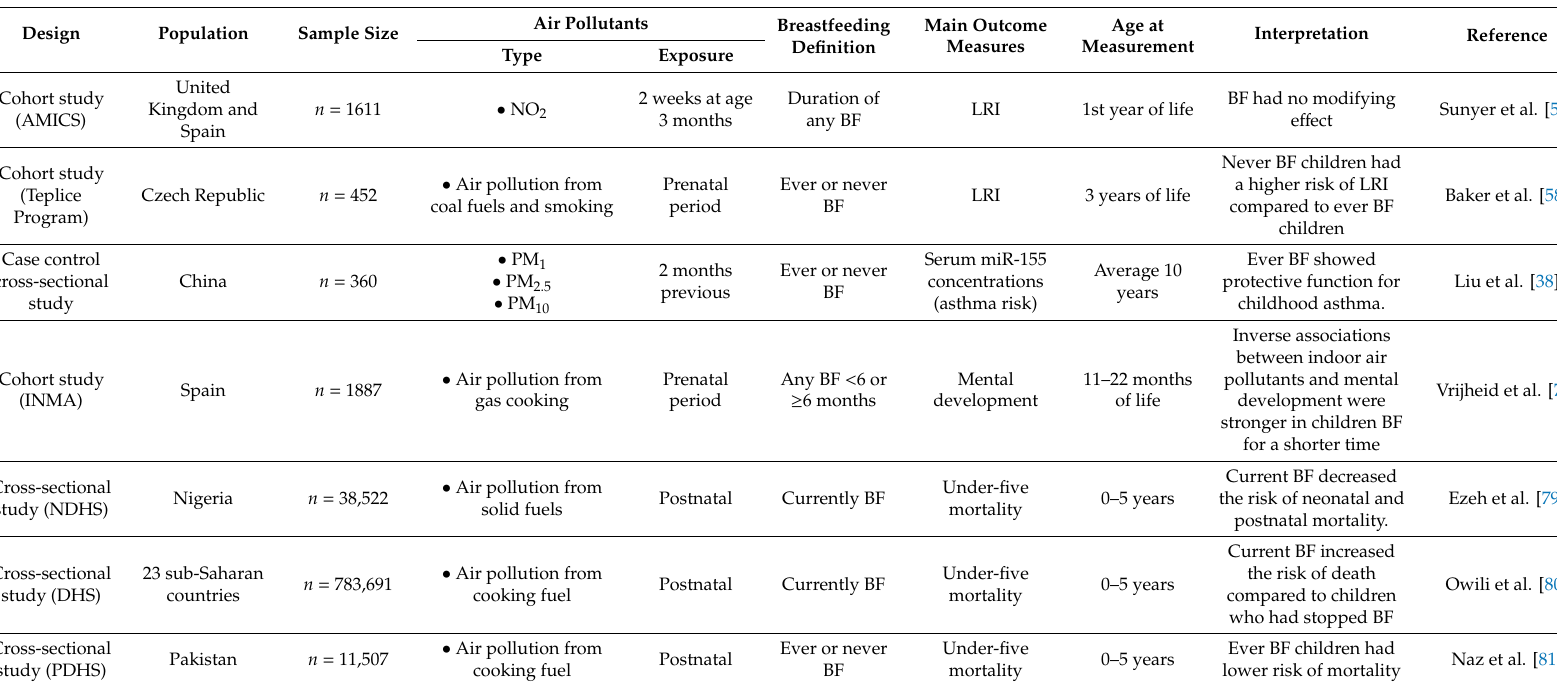
Table 2. Studies investigating the influence of breastfeeding on health e ff ects induced by indoor air pollution exposure in the first 1000 days of life.